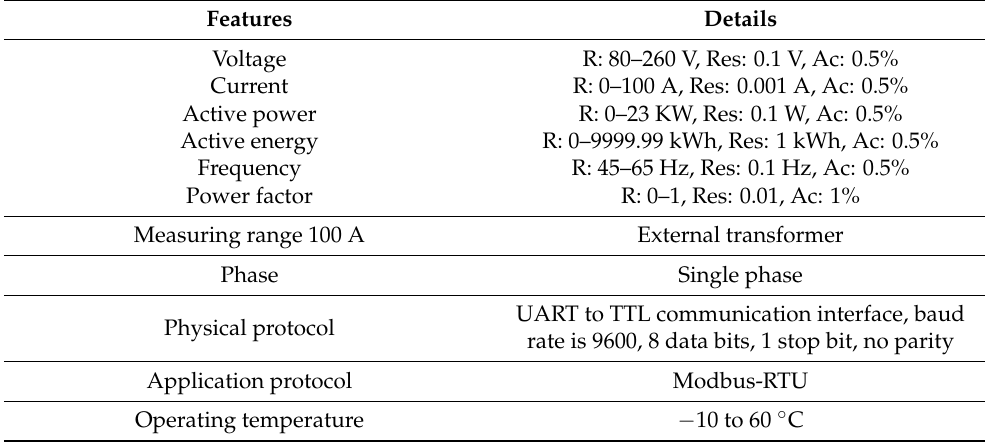
Table 3. Features of PZEM-004T V3.0